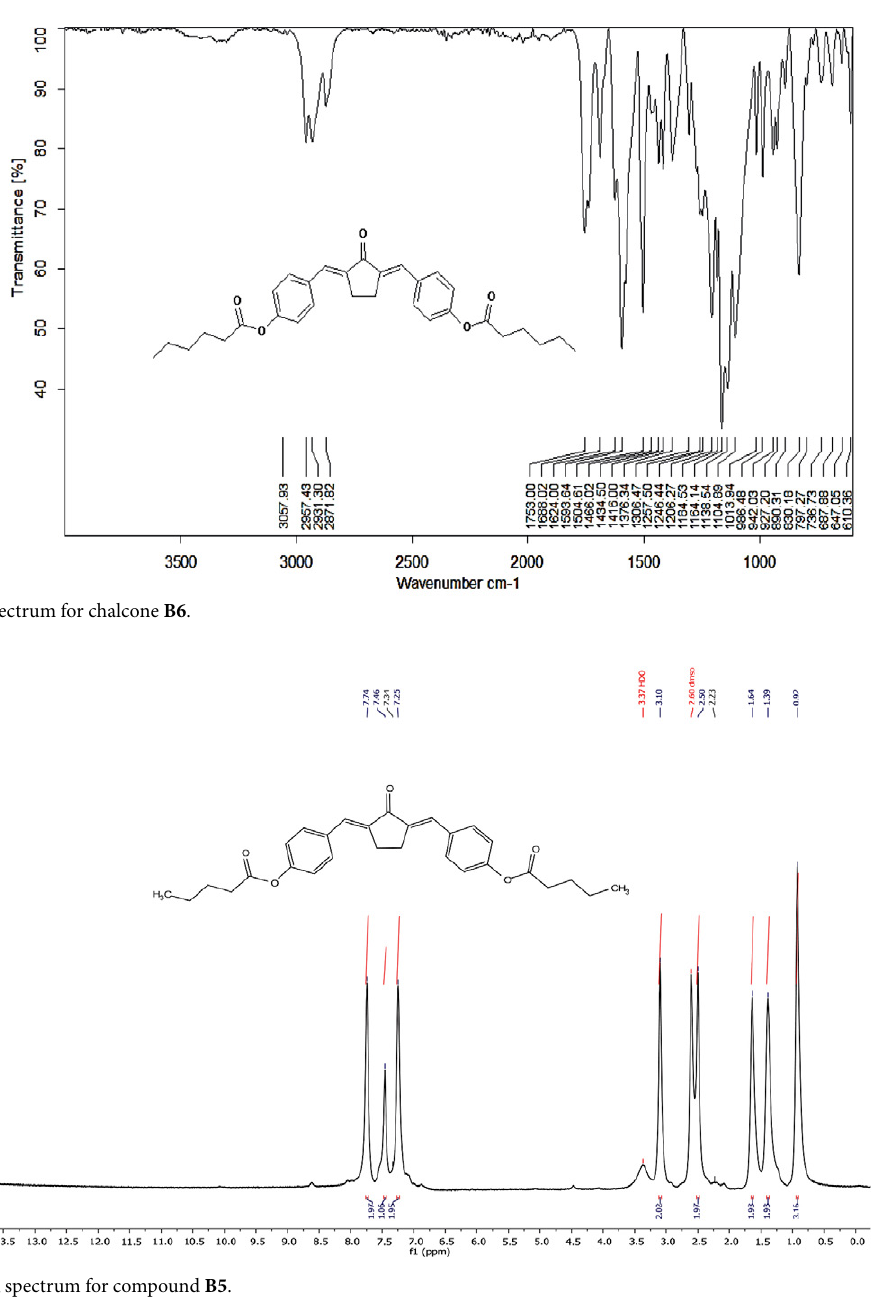
Figure 5 : 1 H NMR spectrum for compound B5